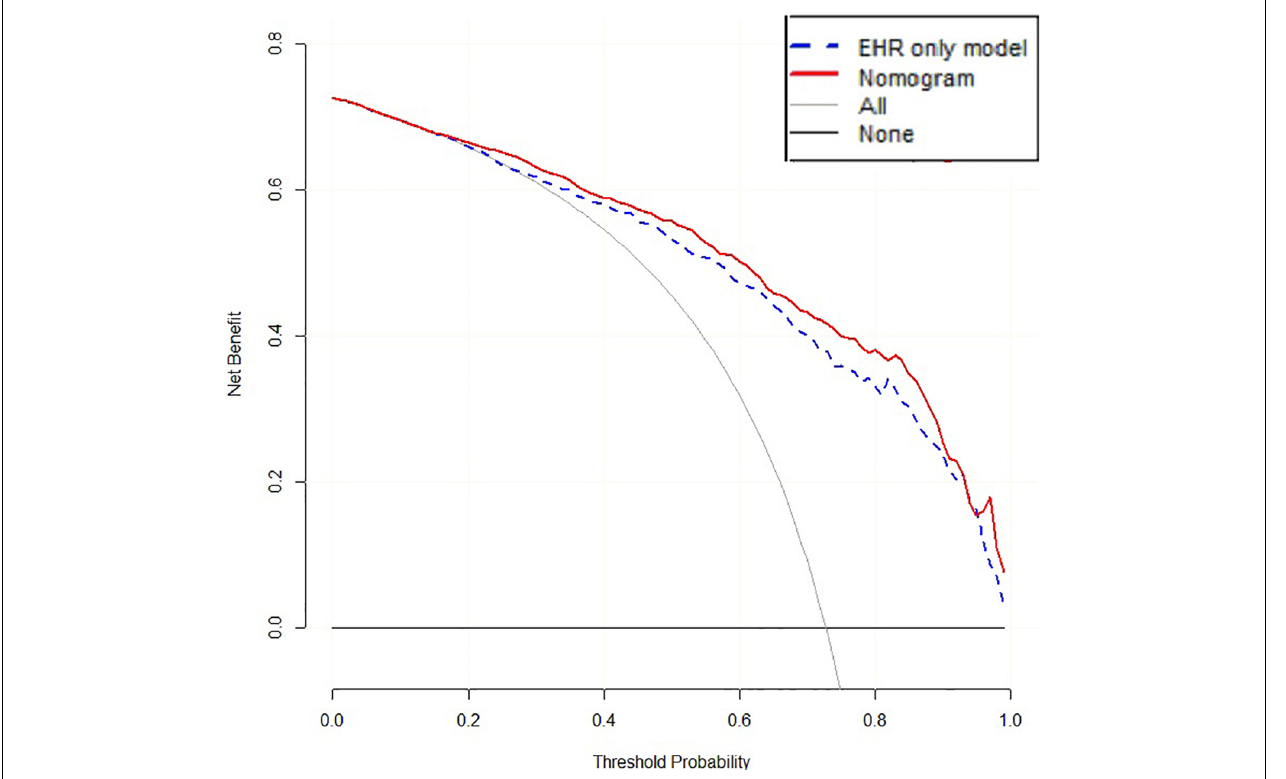
FIGURE 6 | DCA of the “EHR” model and